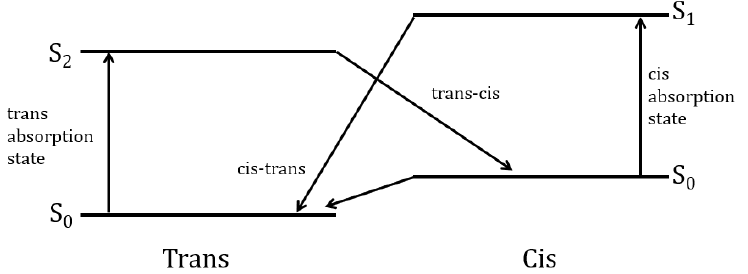
Figure 11. Four level diagram describing trans - and cis - isomerization.